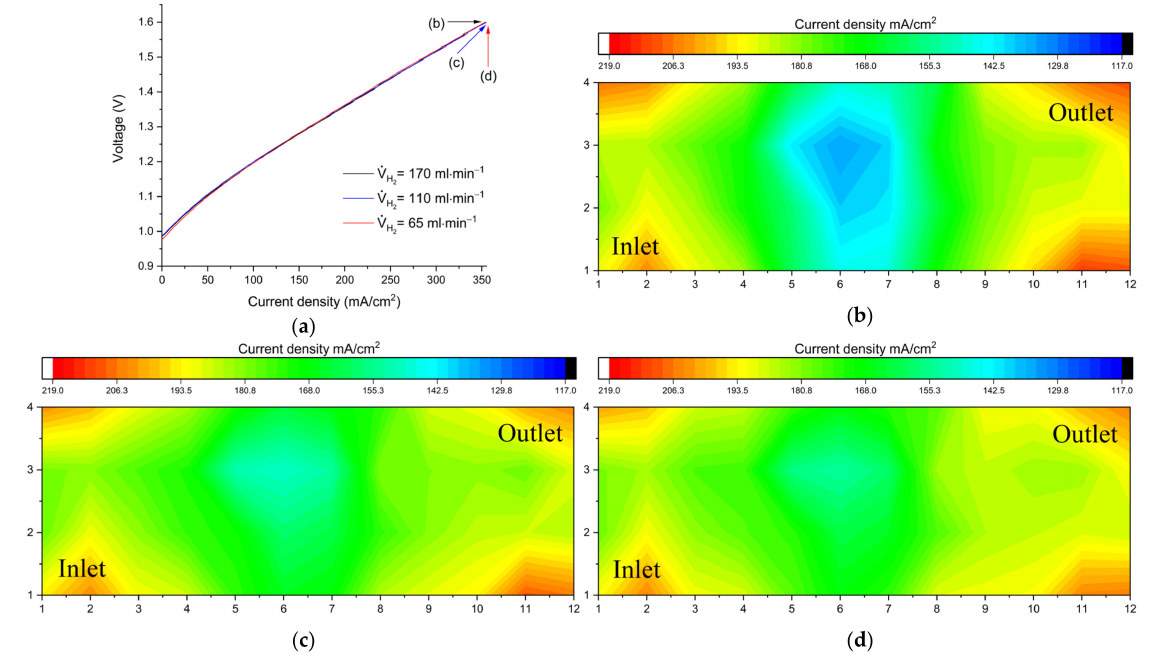
Figure 3. ( a ) Polarization curves (charge) for different anolyte flow rates and corresponding current distributions at limiting conditions for ( b ) V H2 = 170 mL min − 1 , ( c ) V H2 = 110 mL min − 1 and ( d ) V H2 = 65 mL min − 1 . The supply of Br 2 solution was fixed to V Br2 = 30 mL min − 1 .